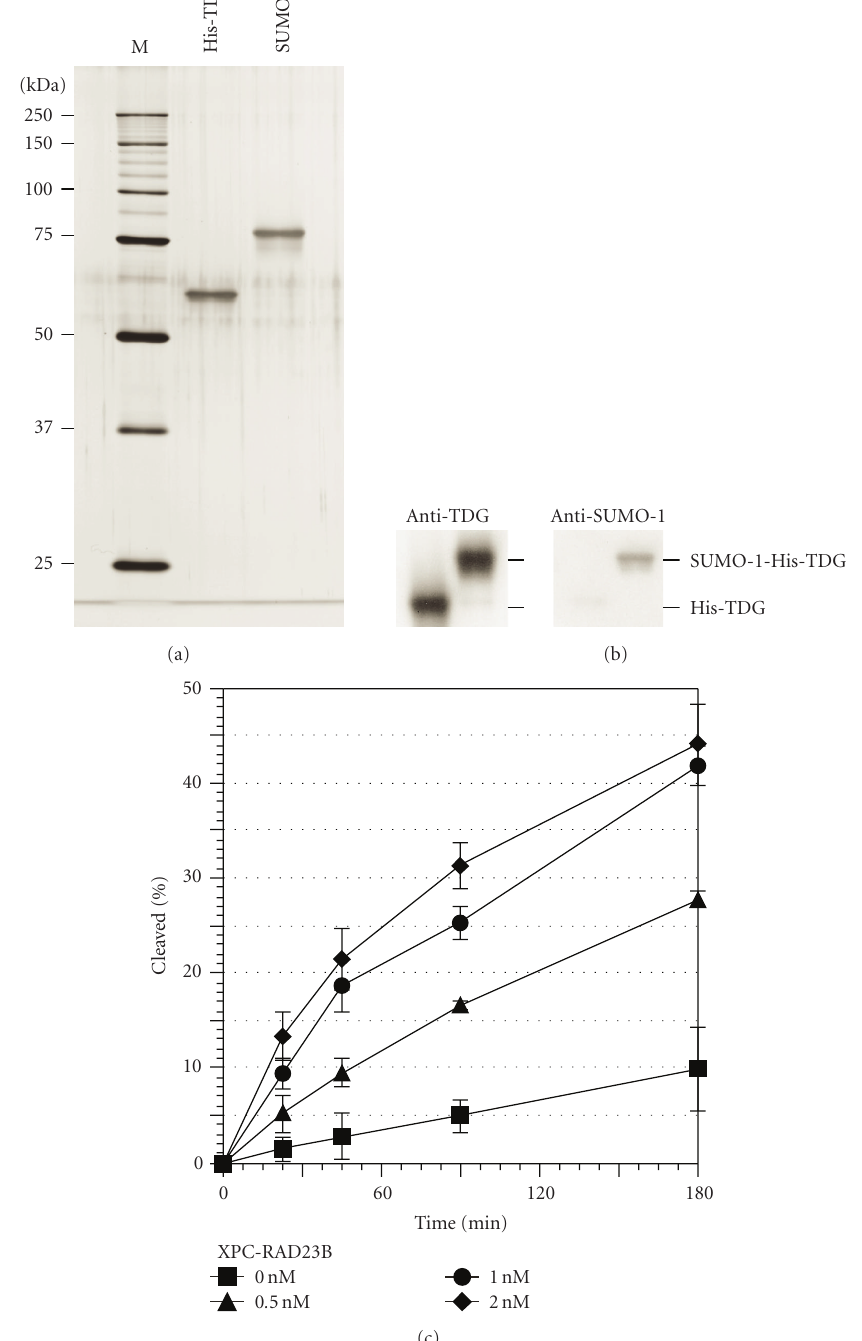
Figure 5: The e ff ect of XPC on the activity of SUMO-1-modified TDG that cleaves uracil from G/U mismatches. (a) Silver staining of the purified recombinant nonmodified His-TDG and SUMO-1-modified His-TDG. M represents the size marker. (b) The sumoylation of TDG was verified with western blot analyses using anti-TDG antibody (left) or anti-SUMO-1 antibody (right). (c) The activity of sumoylated His-TDG was measured by using 1.6nM of 60-bp DNA containing a single G/U mismatch as a substrate. The reaction was done at 30 ◦ C for the time indicated with 2nM SUMO-1-conjugated His-TDG in the presence of XPC-RAD23B. The DNA samples were then purified and subjected to alkali-treatment to cleave the resulting AP sites and separated with denaturing PAGE. The ratio of the cleaved product was calculated and plotted as a graph. The mean values and standard errors were calculated from at least two independent